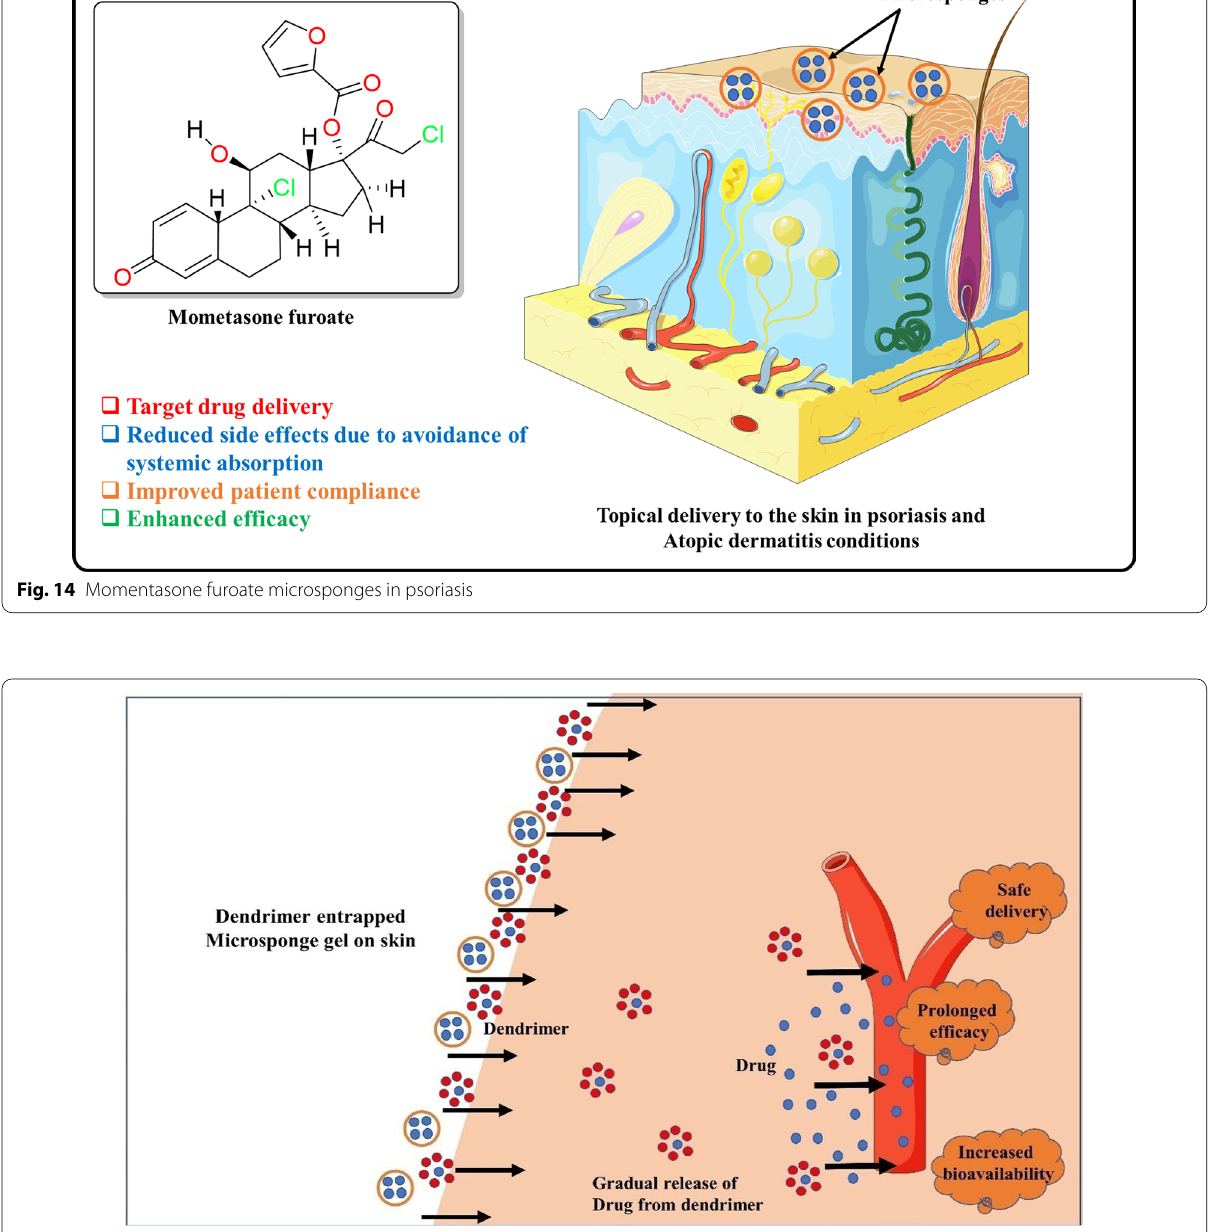
non-irritating in a Draize patch test. The drug release from the ointment lasted up to 4 h, whereas the release from the microsponge gel lasted up to 10 h [44].